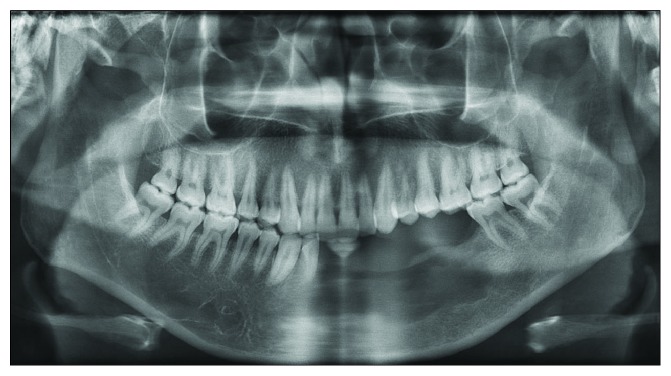
Orthopantomogram.